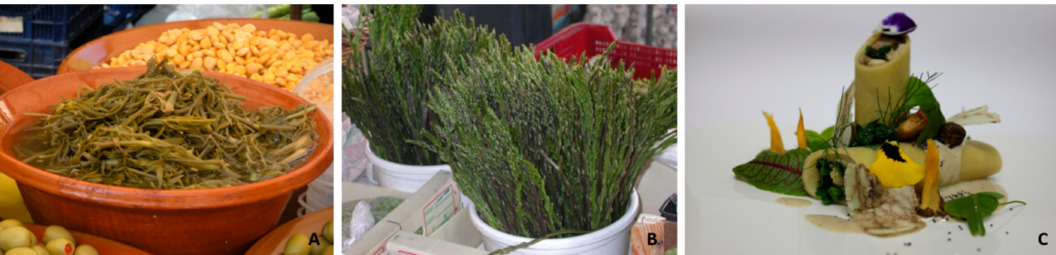
Figure 7. Examples of wild food plants present in markets ( A , B ) or restaurants ( C ). ( A ) Crithmum maritimum ; ( B ) Aspara- gus acutifolius ; ( C ) Urtica dioica